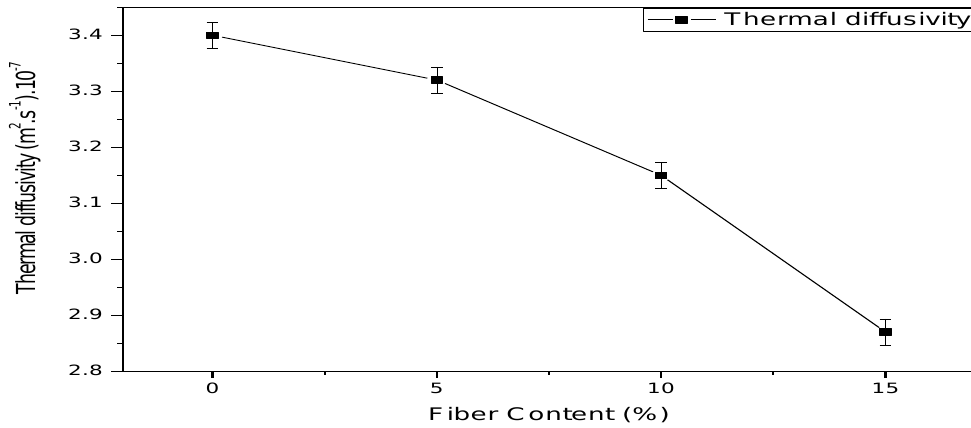
Figure 13. Thermal diffusion in terms of fiber content.